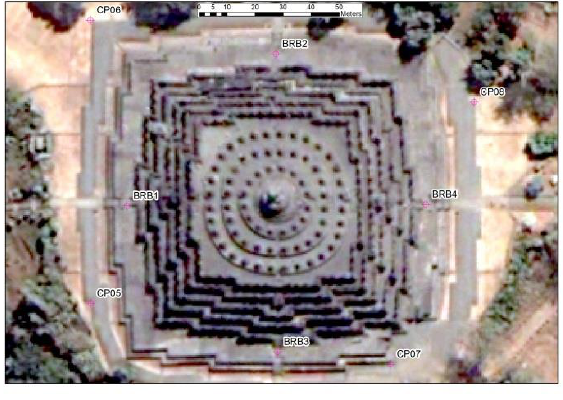
Figure 12. GIS data